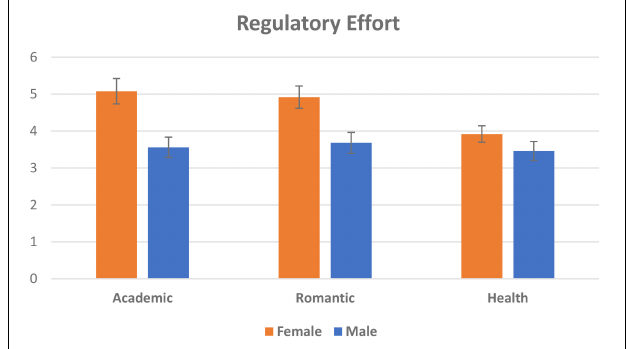
FIGURE 1 | Means and standard deviations for gender differences in regulatory effort within each scenario. Error bars represent the standard error of the means.